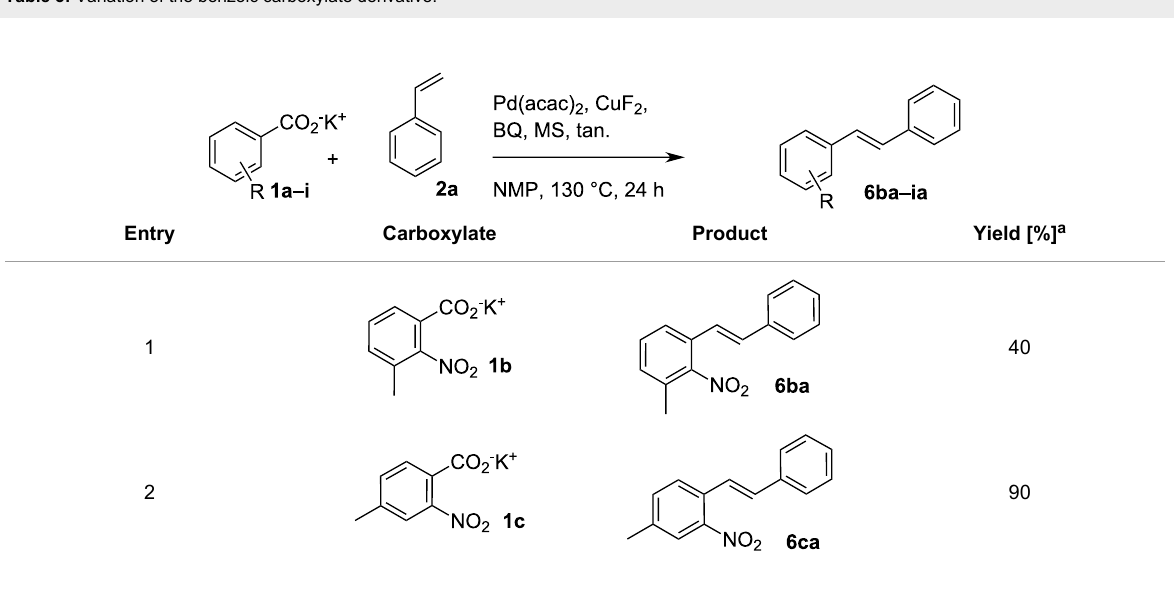
Table 3: Variation of the benzoic carboxylate